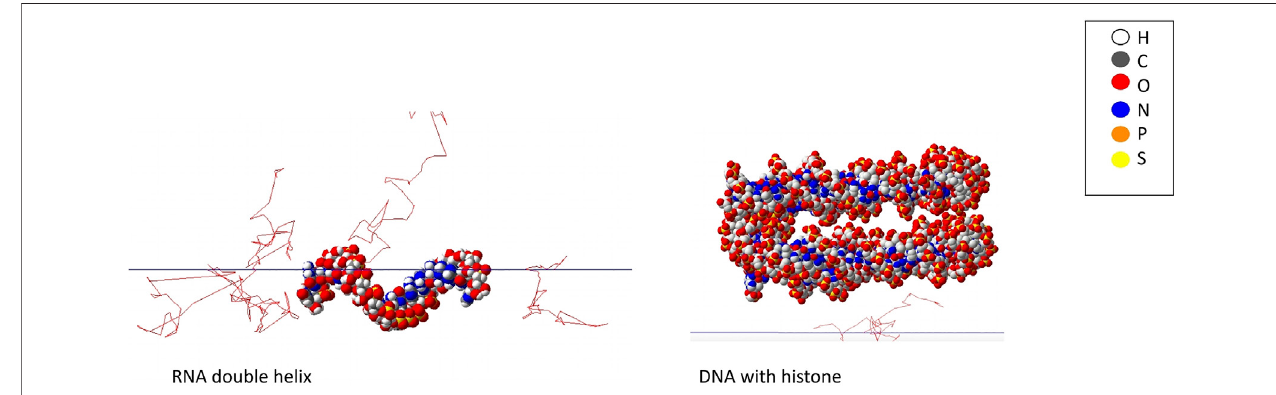
FIGURE5| Molecules fromtheproteindatabank readintoTOPAS-nBiowithaprotontrack(blue)and secondary electrons(red). Twonucleic acidsareshown;an RNA strand and a nucleosome.